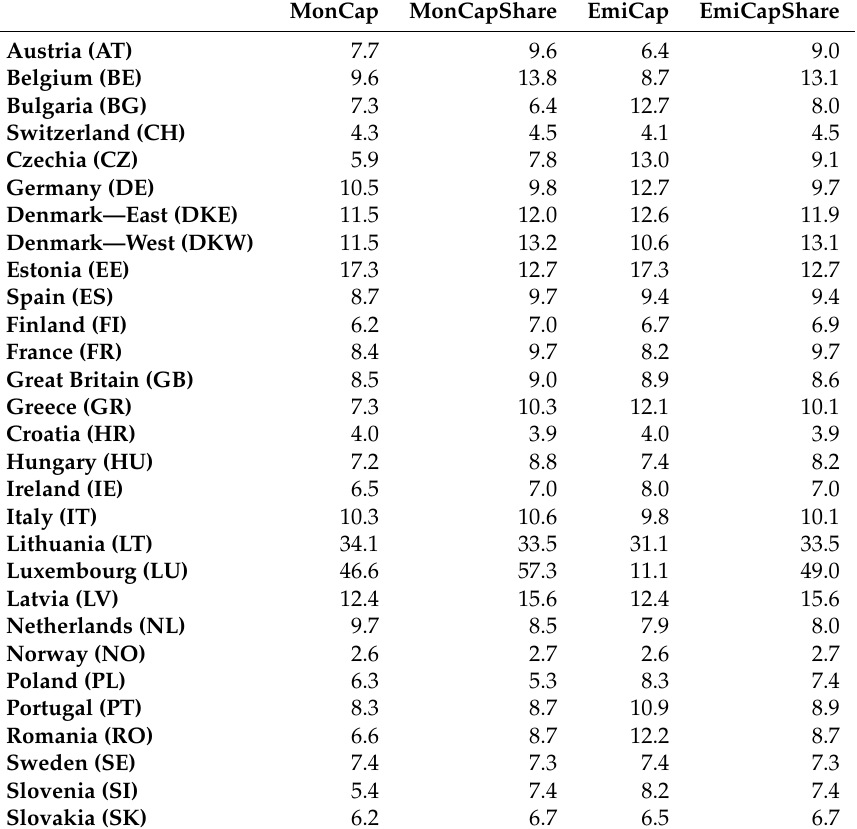
Table A1. Levelized cost of electricity by scenario and country [Cent 2015 /kWh].